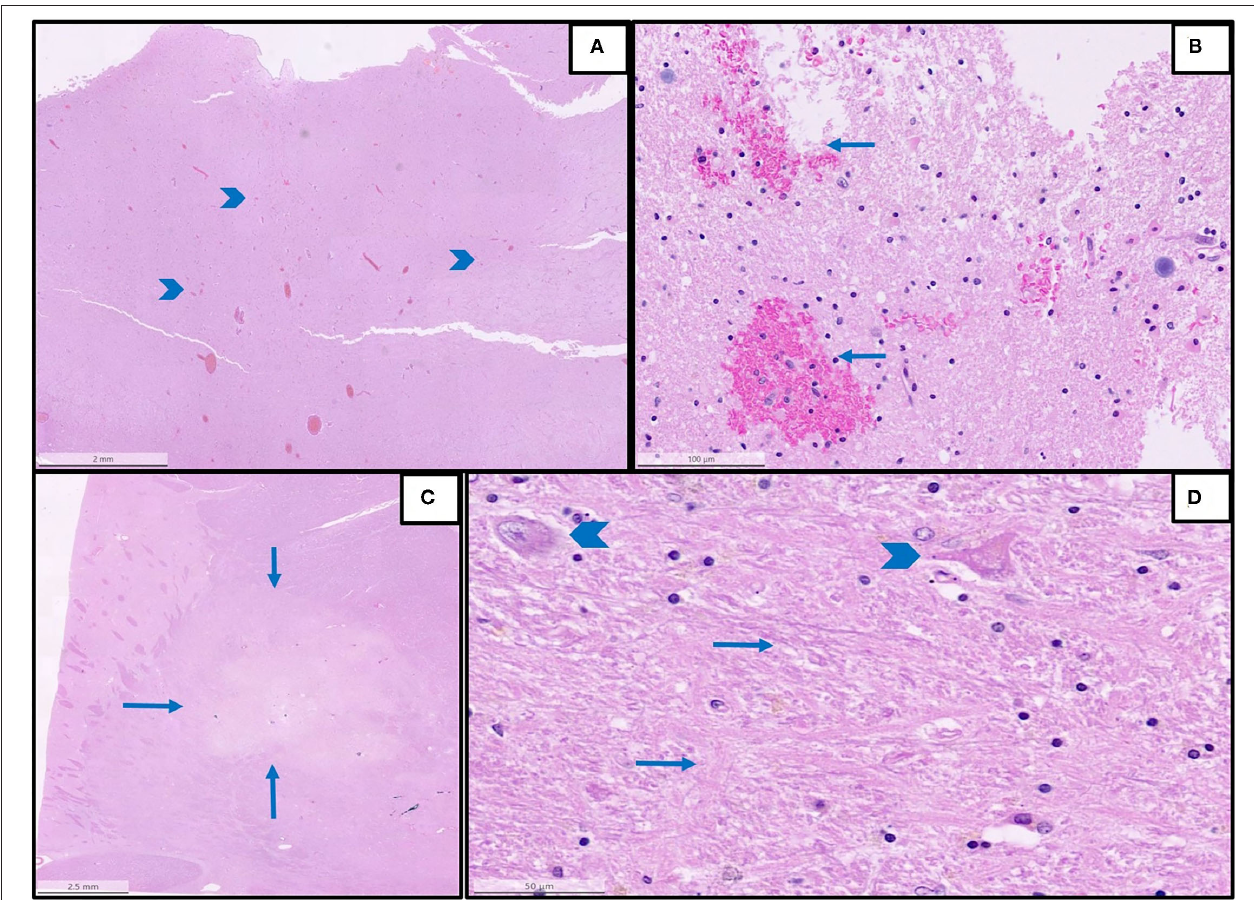
FIGURE 2 | Representative histopathological findings in autopsies from the first wave. (A) An overview of multifocal intracerebral microhemorrhages (arrowheads) in a sample from the brain stem (H&E, magnification 1.2 x). (B) The detail of image A with microhemorrhages (magnification 25 x, arrows: microhemorrhages). (C) An overview of acute brain infarction (arrows) in a sample from basal ganglia (H&E, magnification.62 x). (D) Details of image C showing red neurons (arrowheads) and beginning necrosis (arrows) of brain tissue (H&E, magnification 40